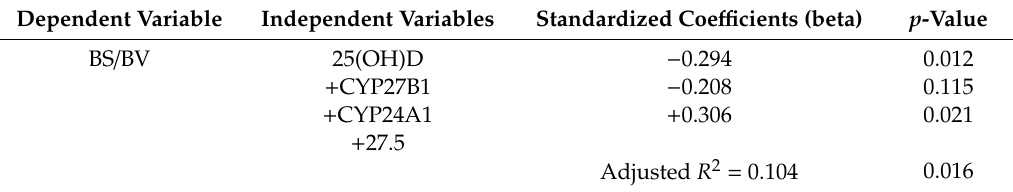
Table 5. Multiple linear regression analyses for serum 25(OH)D, CYP27B1 and CYP24A1mRNA levels as determinants of Bone Surface / Bone